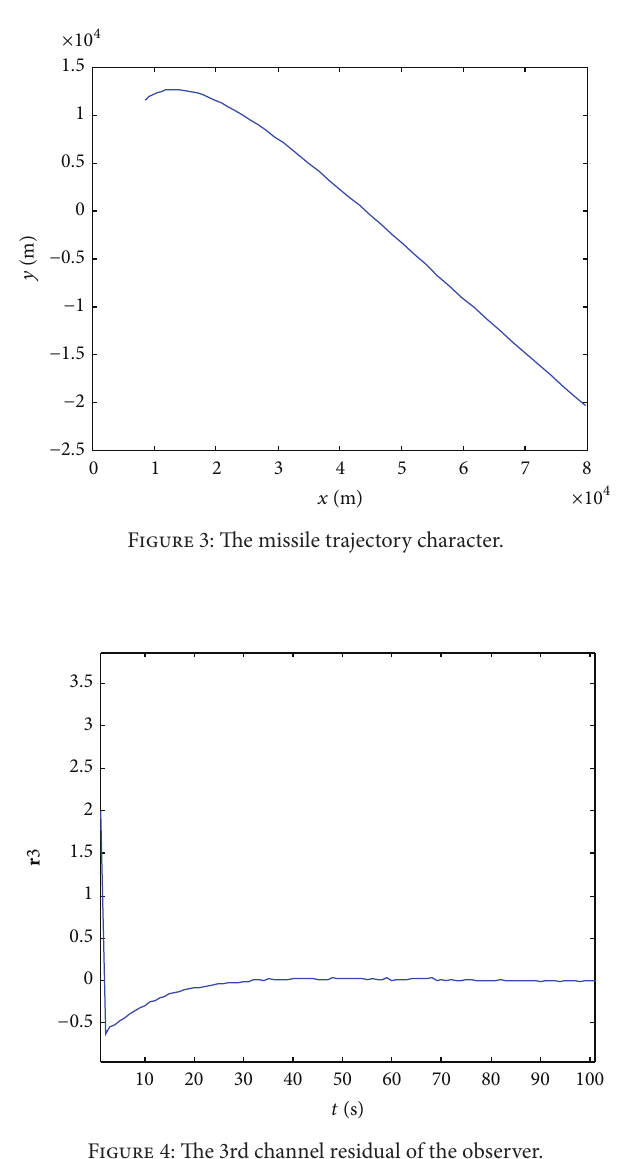
Figure 4: The 3rd channel residual of the